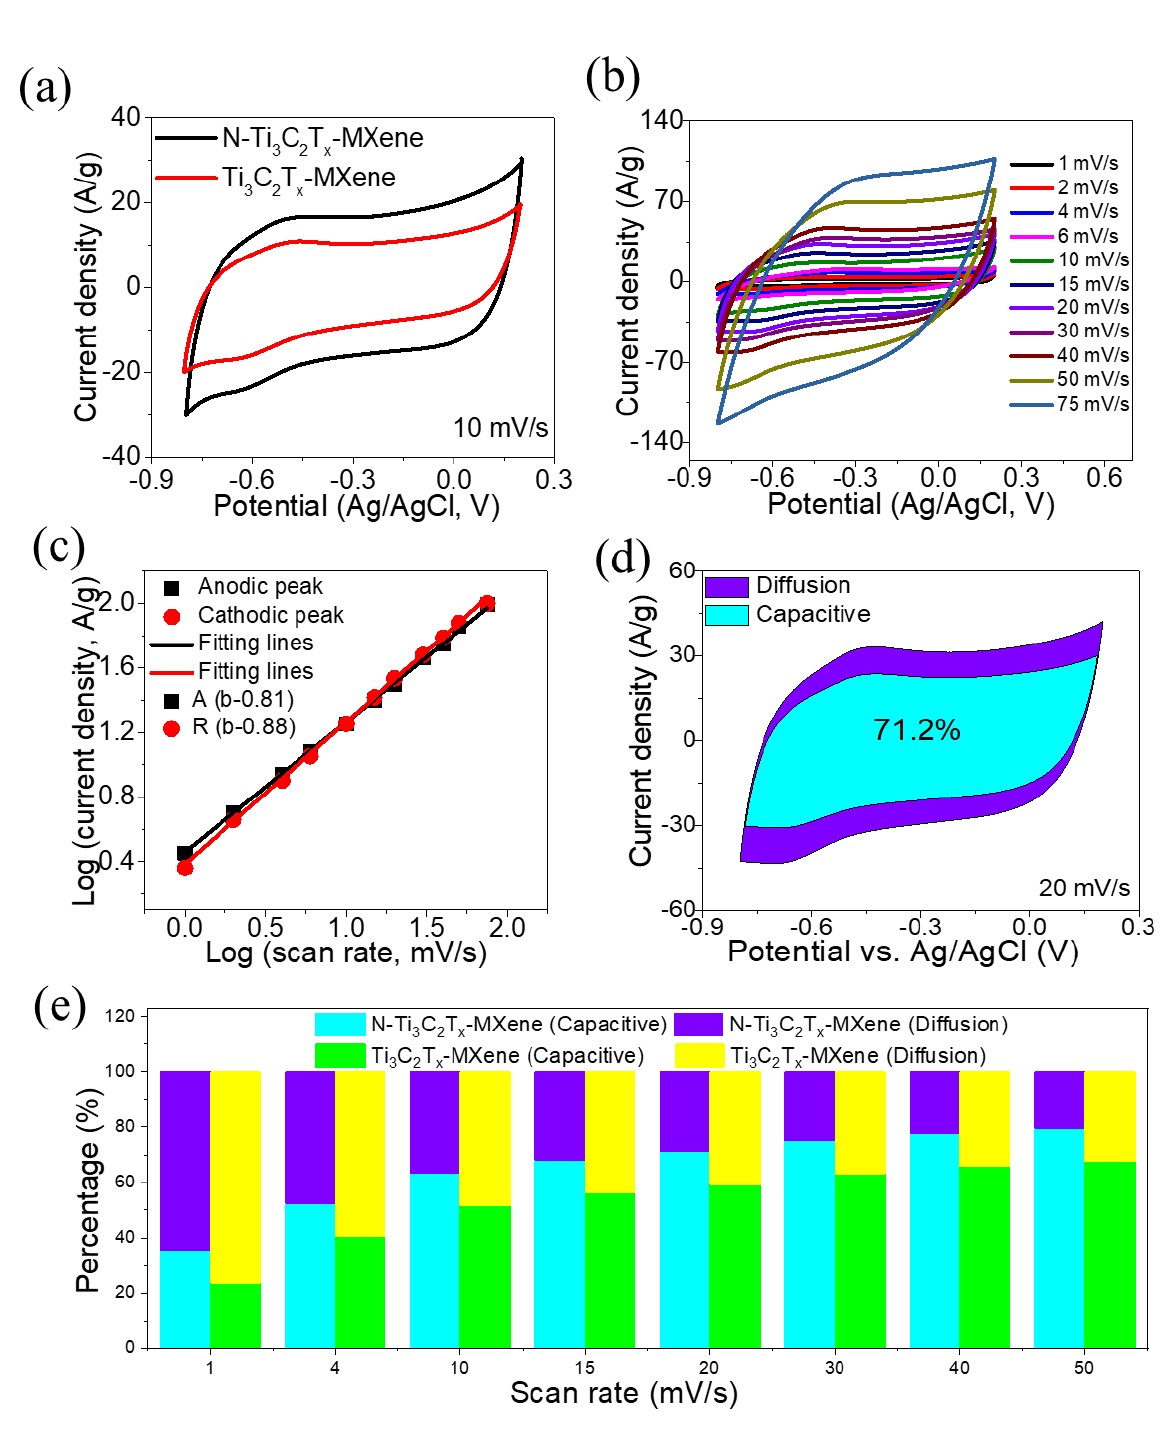
Figure 4. ( a ) CVs of Ti 3 C 2 T x -MXene and N -Ti 3 C 2 T x -MXene at -0.8-0.2 V; ( b ) CVs of N -Ti 3 C 2 T x -MXene at different sweep rates; ( c ) calculation of b -values log (current density) versus log (sweep rate); ( d ) percentage contribution of diffusion/capacitive mechanisms; and ( e ) percentage contribution of diffusion/capacitive mechanisms at different sweep rates (1–50